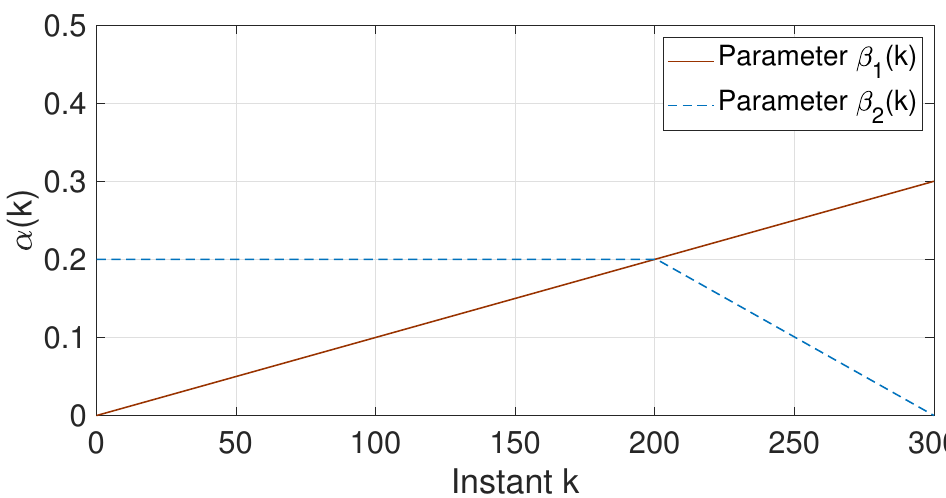
Figure 4. The behavior of the parameters β 1 ( k ) , β 2 ( k ) during each simulation. The parameters β 1 ( k ) , β 2 ( k ) are responsible for representing the time-varying aspect of the transition matrix P ( k ) in (41).